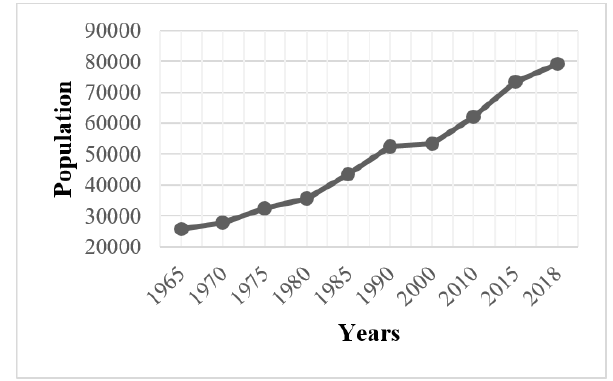
Figure 2. Population Growth by Years.